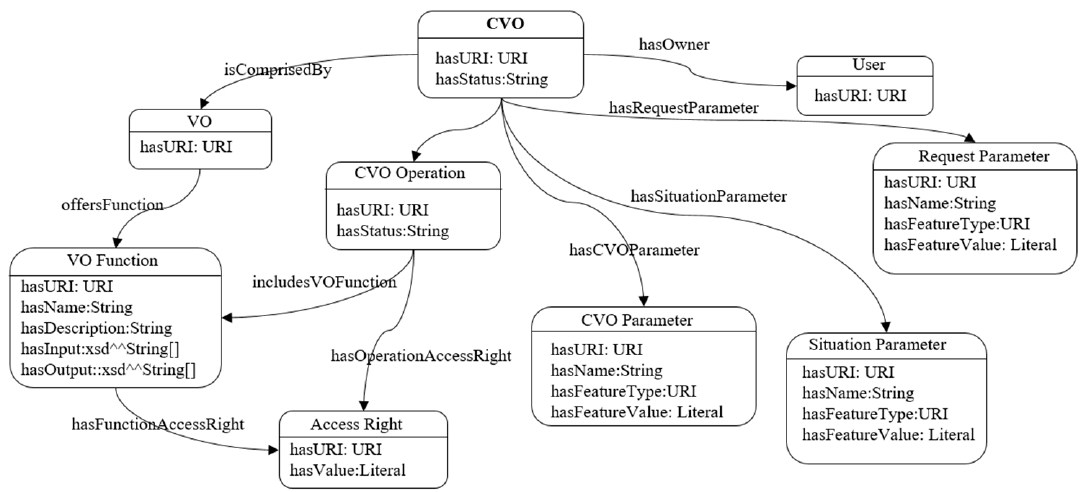
Figure 4. Composite virtual object (CVO) information model.